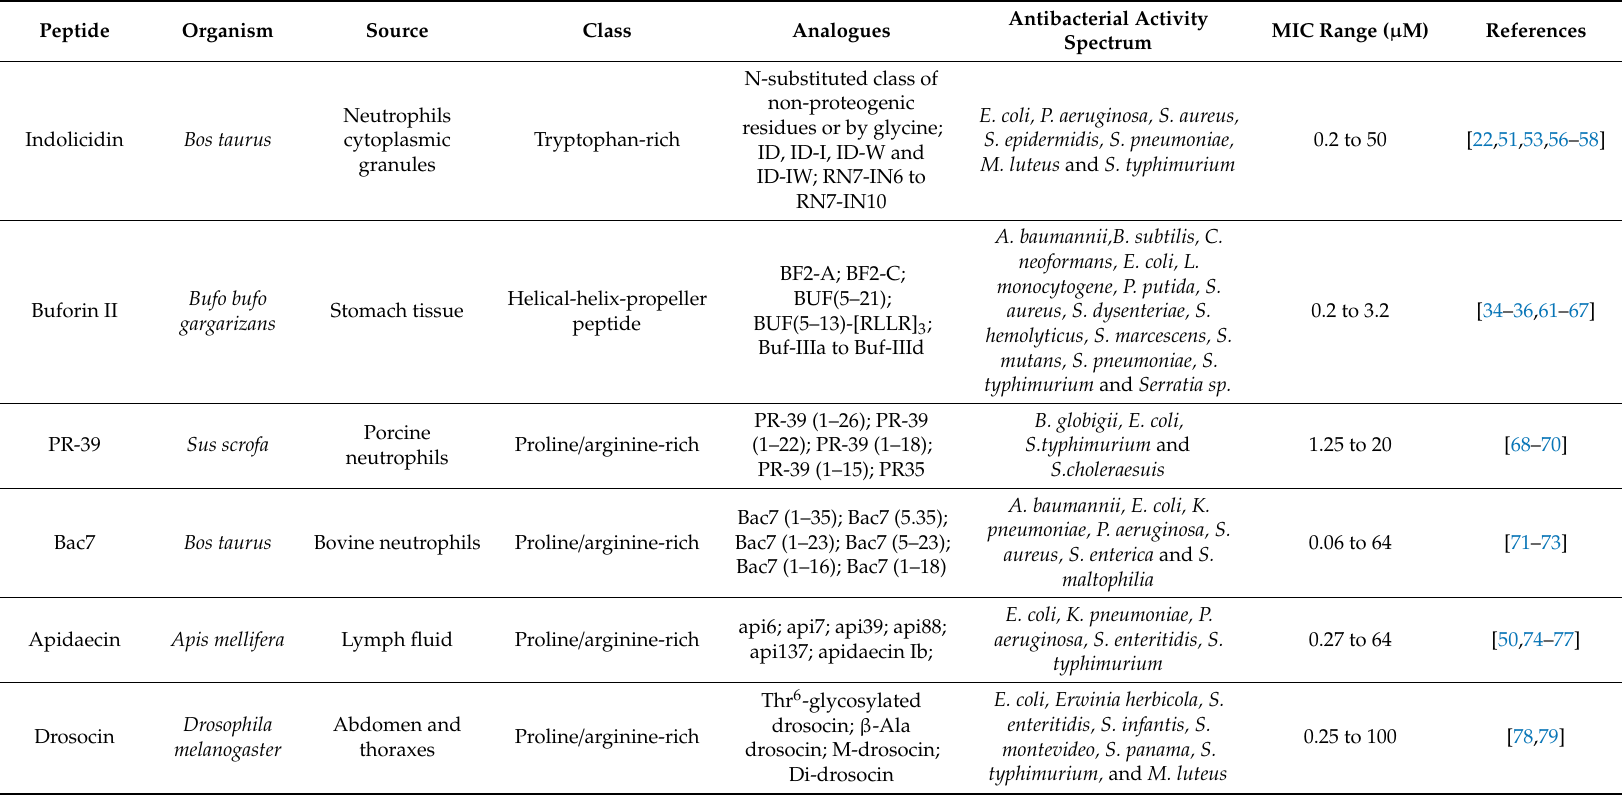
Table 2. Non-lytic peptides, their source organisms, class, analogue peptides, and antibacterial activity